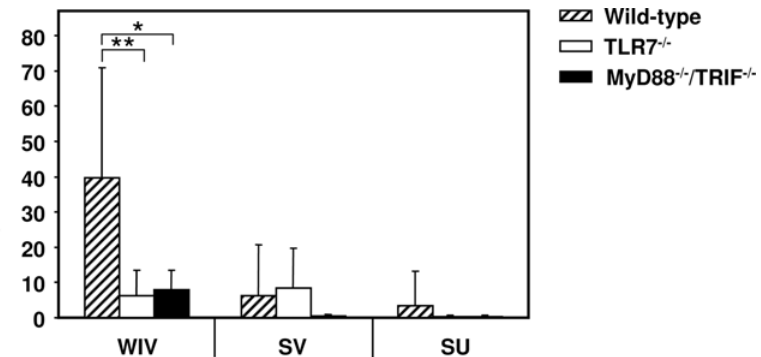
Figure 2. Induction of IFN c -producing T cells by H5N1 WIV vaccine depends on TLR7 signalling. Spleen cells of wild-type mice and mutant mice immunized with WIV, SV, or SU vaccine were re-stimulated in vitro with SU vaccine, and numbers of IFN c -producing cells were determined by Elispot assay. Bars represent the average values of triplicate determinations per mouse for each mouse type and immunization group (n=8; MyD88 2 / 2 /TRIF 2 / 2 /SU, n=7), with standard deviation. Significant ( p , 0.05) and highly significant ( p , 0.01) differences between wild-type mice and mutant mice receiving the same vaccine are indicated by * and **, respectively.